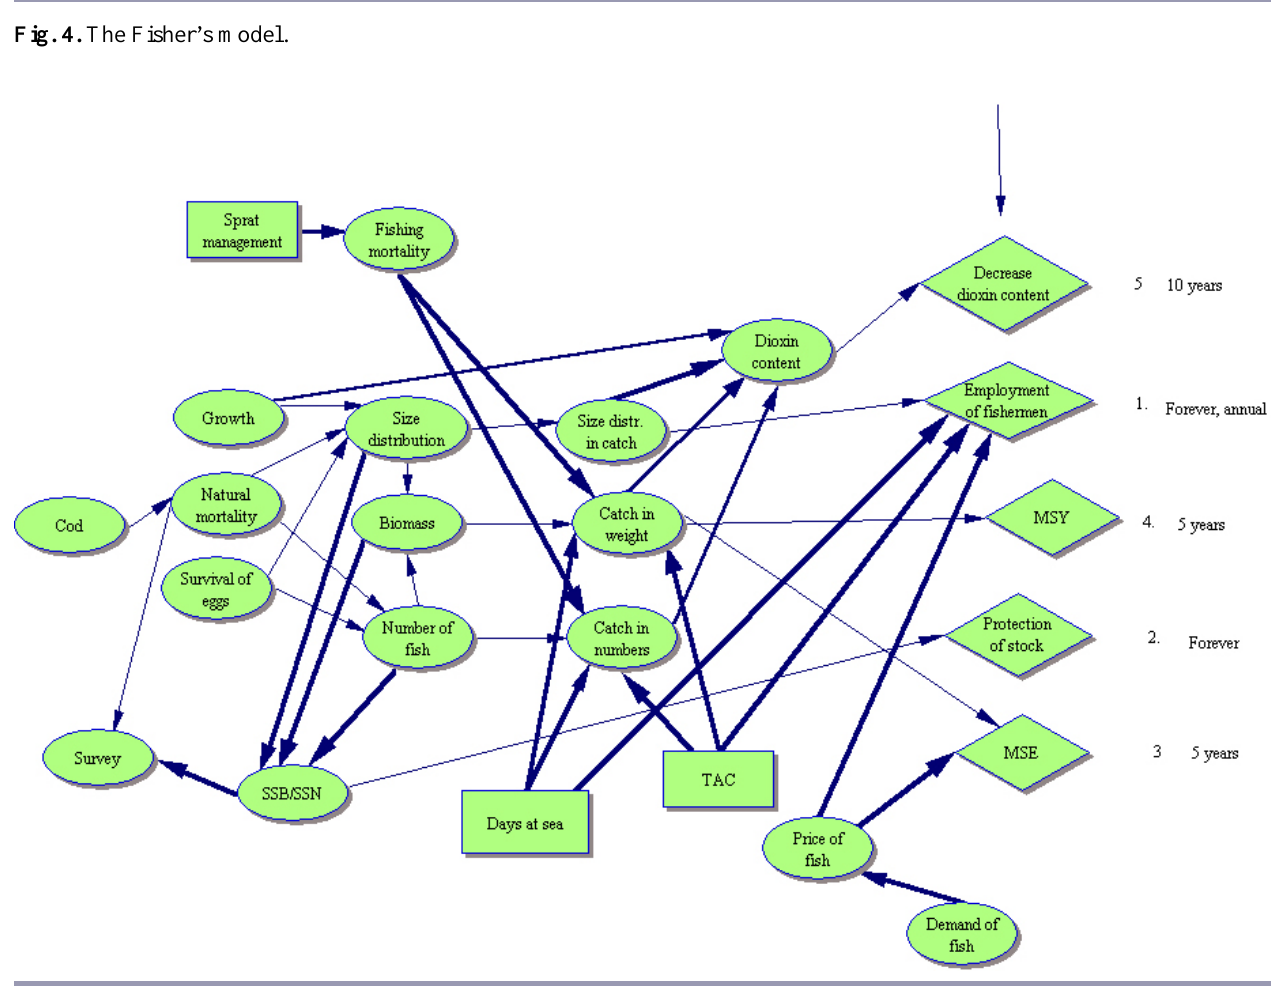
Fig. 4. The Fisher’s